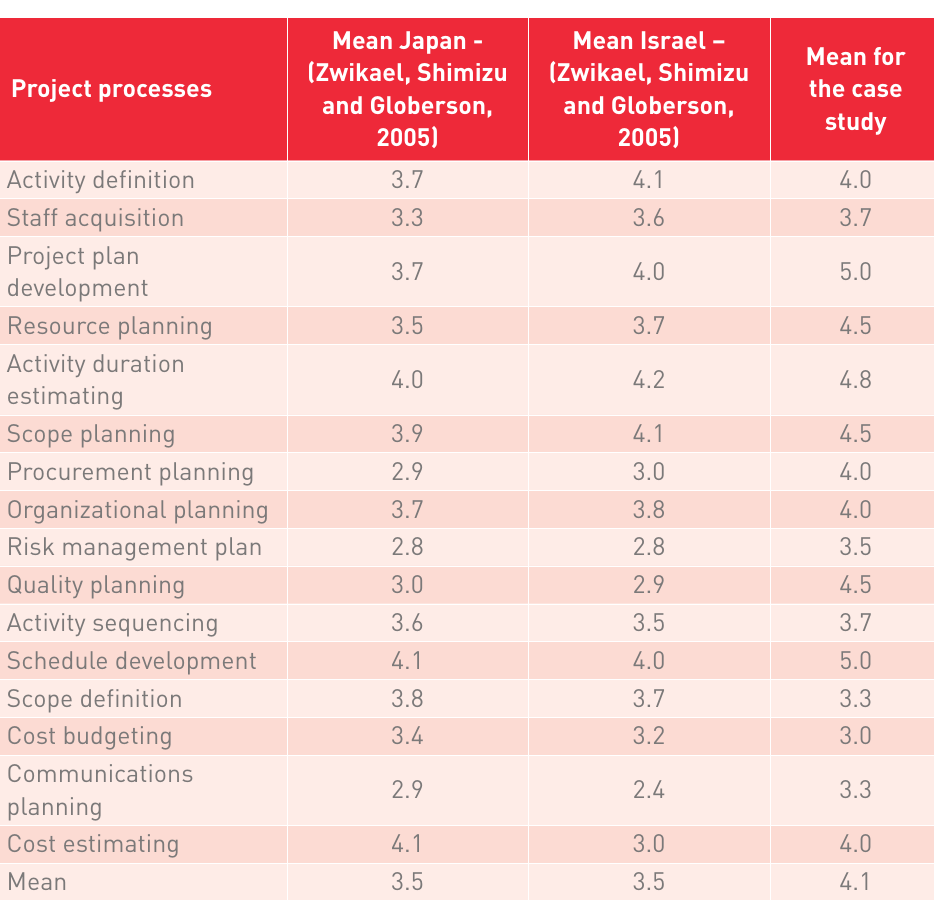
Level of applied pre-planning processes between Japan, Israel and the studied case